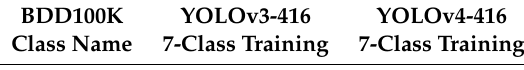
Table 4. AP50 for each class with YOLOv3 and YOLOv4 models trained with BDD100K when applied to the BDD100K test subset.